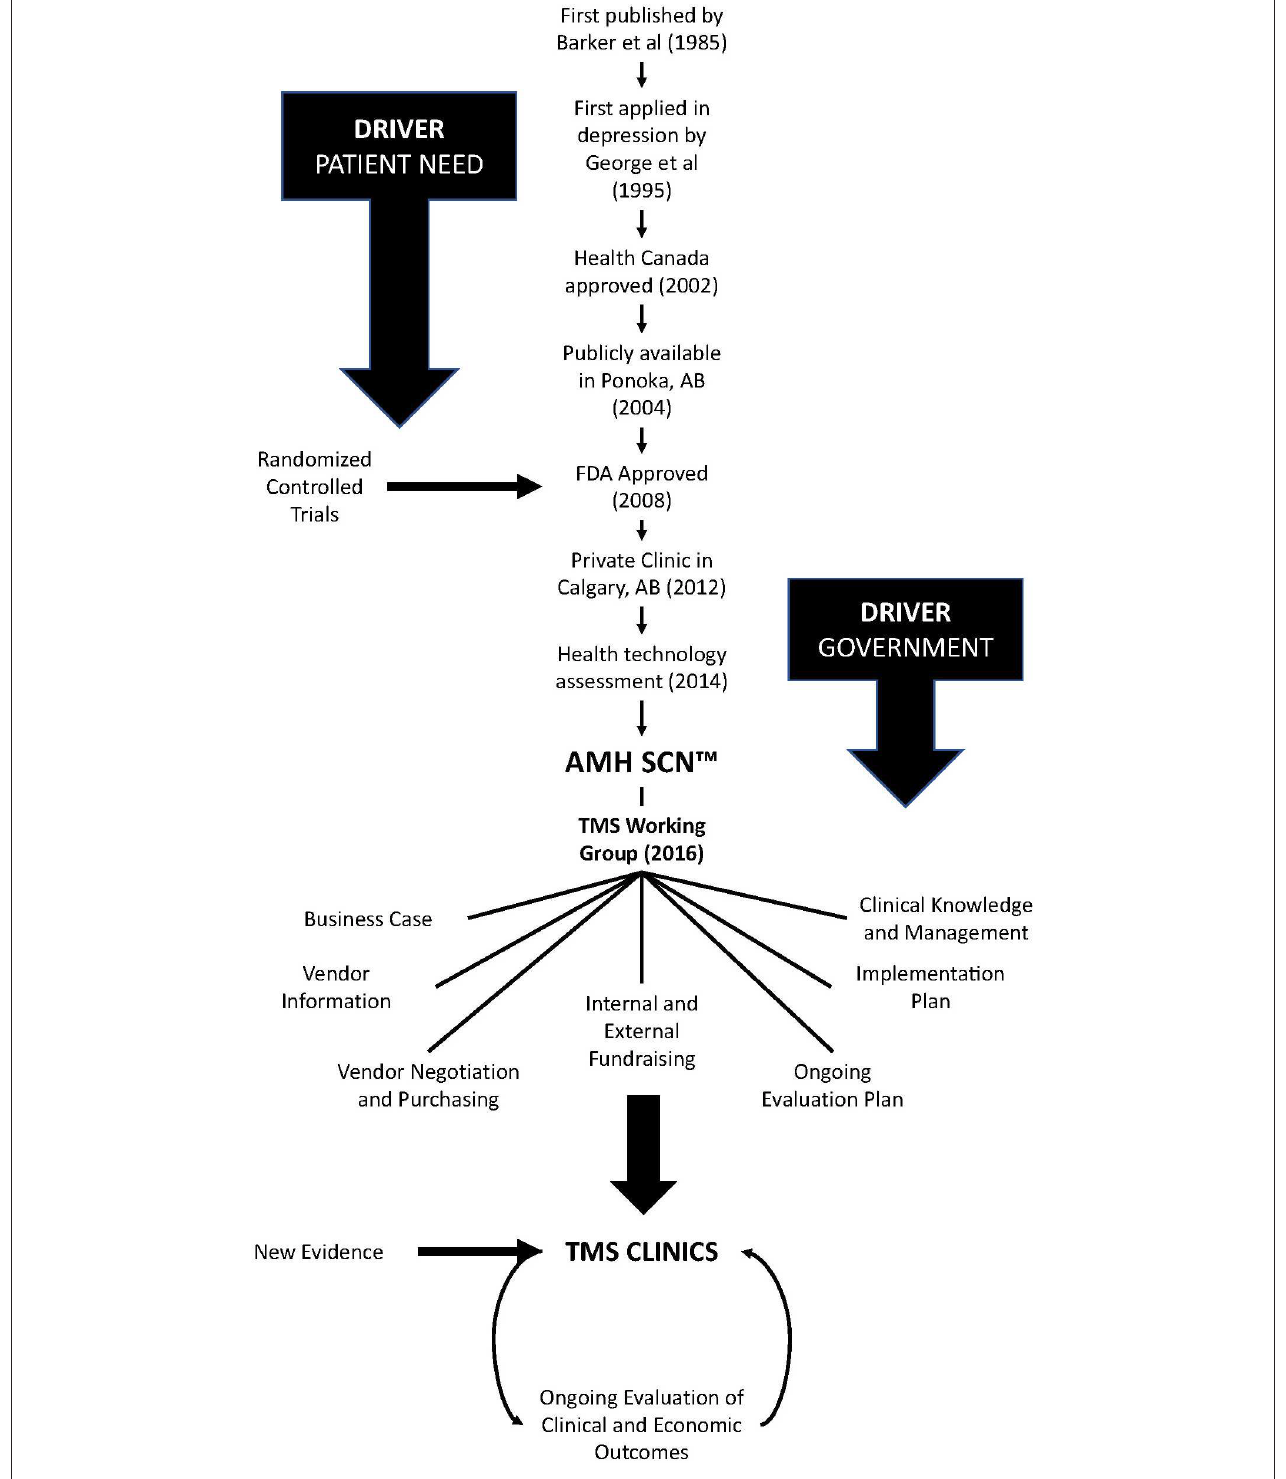
FIGURE 1 | Schematic showing progress of transcranial magnetic stimulation (TMS).